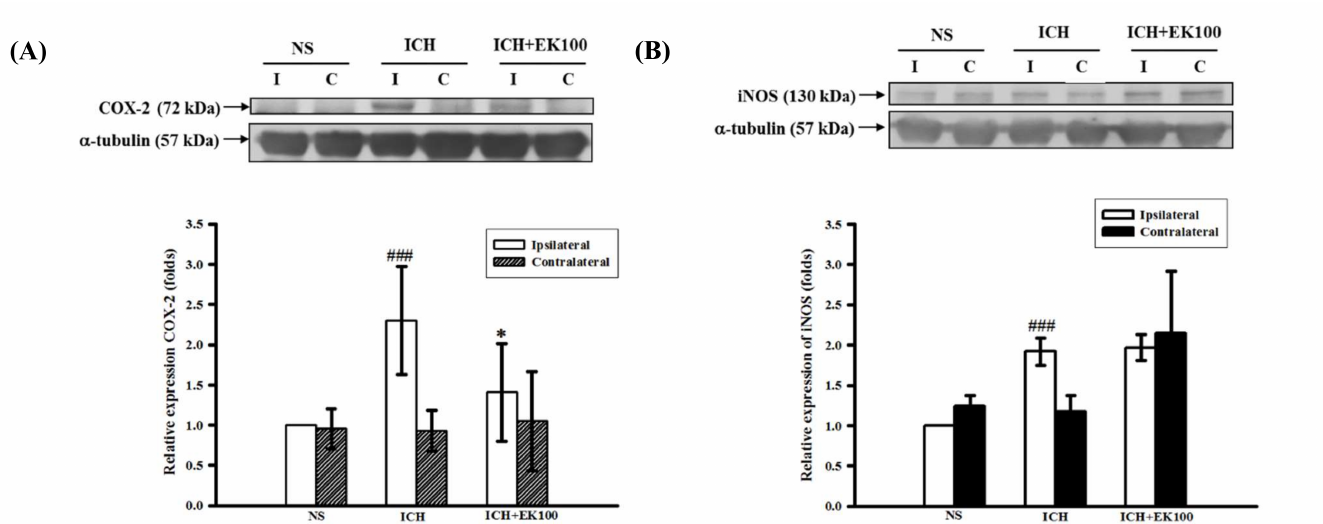
Figure 2. Effects of EK100 on the expression of brain COX-2 and iNOS proteins after ICH. C57BL/6 mice were post-ICH orally administered EK100 (30 mg/kg) at 30 min after the intrastriatal injection of 0.02 U collagenase to induce ICH. Brain slices (3 mm) were obtained at 24 h after ICH, and their ipsilateral (I) and contralateral (C) regions were homogenated and analyzed for the expression of COX-2 ( A , n = 6) and iNOS ( B , n = 5) proteins by Western blots. The relative changes (folds) were represented as the mean ± SD. ### p < 0.001 compared with ipsilateral NS-intrastriatal injected with vehicle treatment group; * p < 0.05 compared with ipsilateral collagenase-intrastriatal injected with vehicle treatment